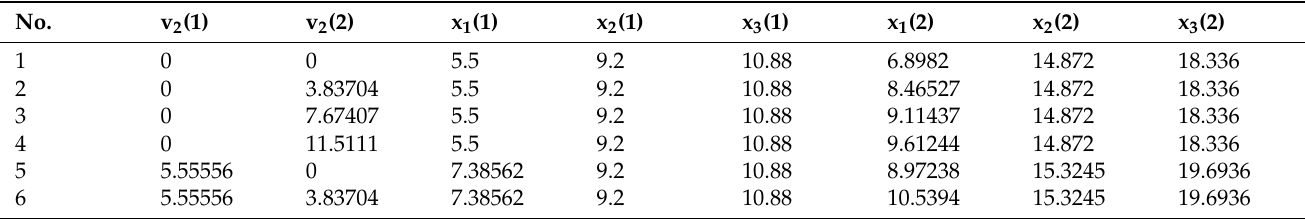
Table 4. Strategies of the second influence agent under fixed strategies of the Principal and the first influence agent: r 1 (1) = 0, r 2 (1) = 16.0(6), r 1 (2) = 11.5(1), r 2 (2) = 11.5(1), v 1 (1) = 0, v 1 (2) = 11.511. Opinions of the basic